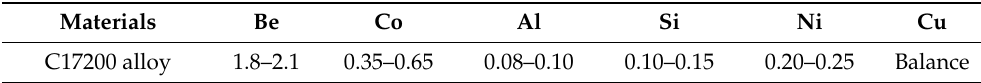
Table 1. Chemical compositions of C17200 beryllium copper alloy (wt. %).